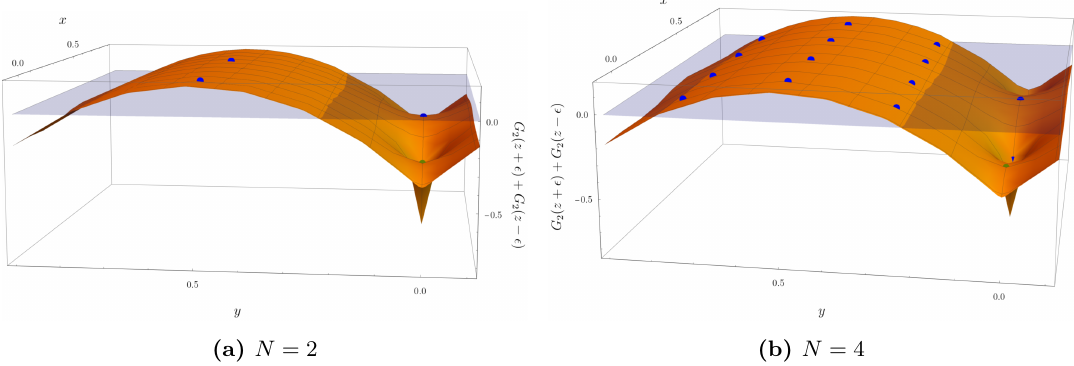
Figure 2. Plot of G tot . for τ = 2 i and (cid:15) = 0 . 1 . The blue dots are the ED3 open string landscape points, and the green one z = 0